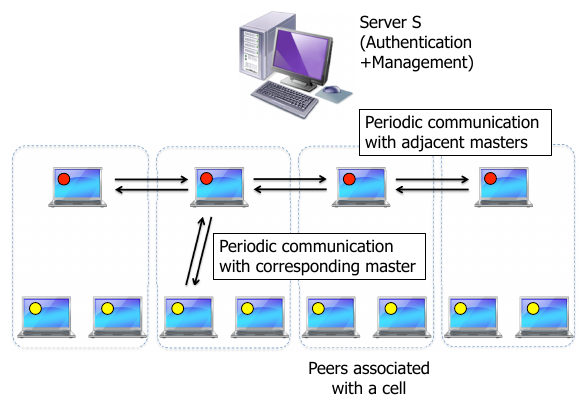
Fig. 3. Communication among peers in the P2P model used in MOPAR (peers with red circle represent masters).